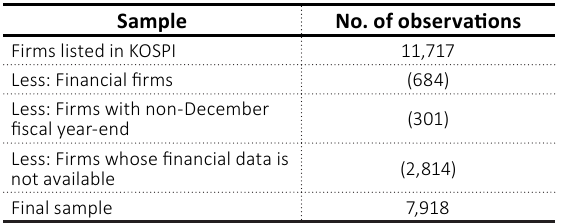
Table 1. Sample selection